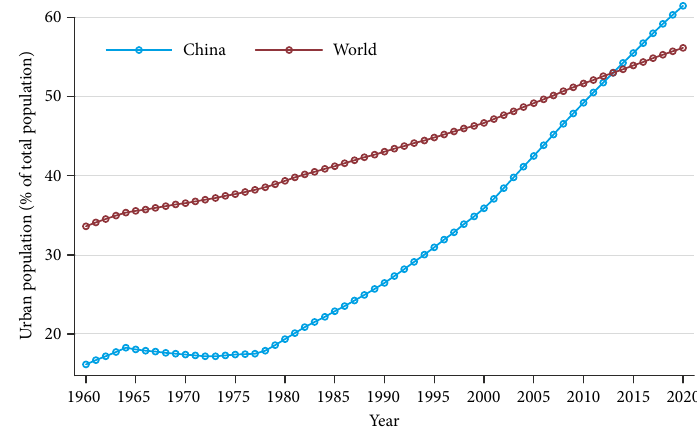
Figure A1. Evolution of urban population (% of total population) in China and the world during 1960–2020 (data sources: the World